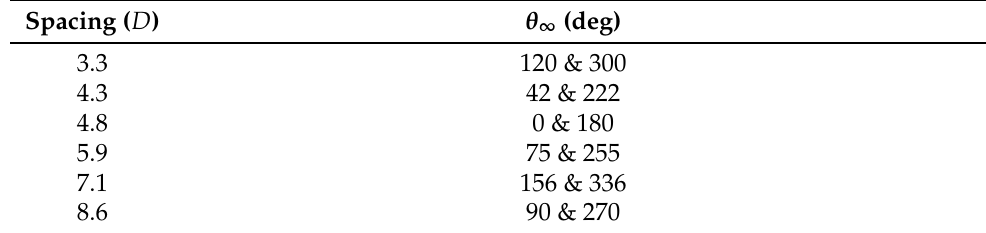
Figure 1. Visualization of the Lillgrund wind farm: ( a ) shows the layout of the wind farm ( b ) shows the different turbine spacings. Table 1. The alignment wind directions per turbine